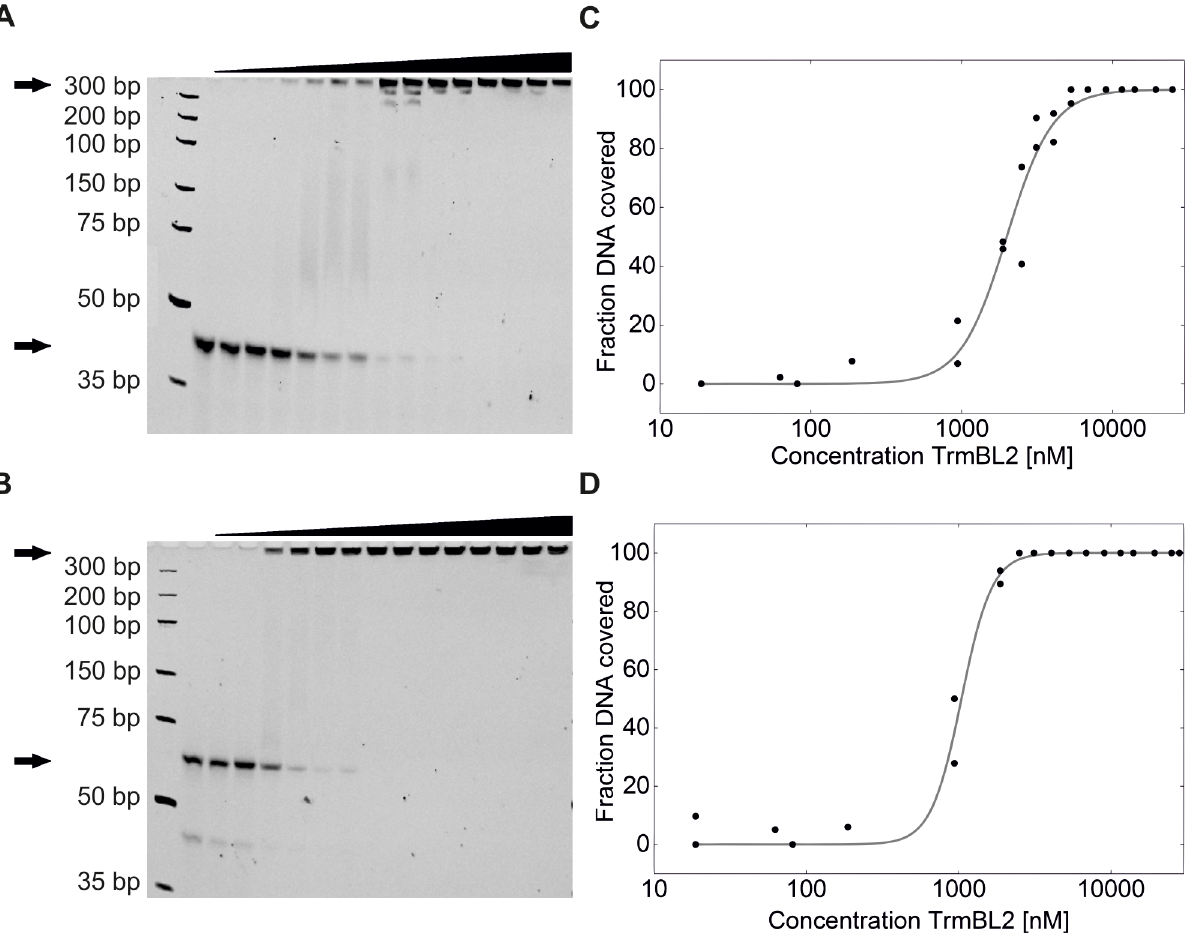
Fig 6. Gel shift assay of TrmBL2 binding to ssDNA and dsDNA. The lanes contained TrmBL2 at increasing concentration (solid black ramp) and DNA. (A) Gel of ssDNA incubated with TrmBL2 at different concentrations. Marked with arrows are the ssDNA/TrmBL2 complex (top) and the ssDNA alone (bottom). (B) Gel of dsDNA incubated with TrmBL2 at different concentrations. Marked with arrows are the dsDNA/TrmBL2 complex (top) and the ssDNA alone (bottom). Note that unhybridized ssDNA runs at lower molecular weight. The bare dsDNA sample shows 2 bands, one annealed dsDNA band and one ssDNA band which resulted from unhybridised residual 60mer. The unhybridised band made up approximately 5% of the total fluorescence. (C) Titration curve using measured intensities of the bands indicate a K D of 2.0 μ M for ssDNA. Data were fitted using a logistic binding model. (D) Titration curve after analysis of band intensities for TrmBL2 binding to dsDNA indicate a K D of 1.0 μ M. Data were fitted using a Hill